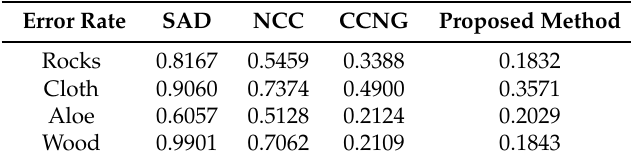
Table 1. Quantitative disparity evaluation with ground truth (error tolerance = 1).